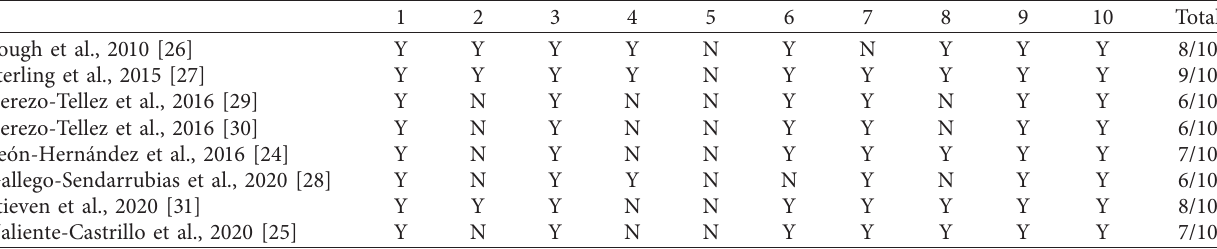
Table 2: Score of randomized clinical trials with the PEDro scale.